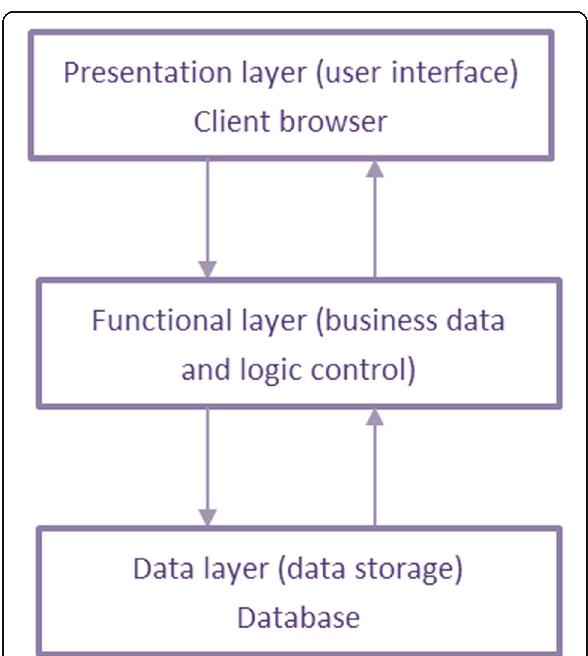
Fig. 6 Overall structure of the intelligent commodity push